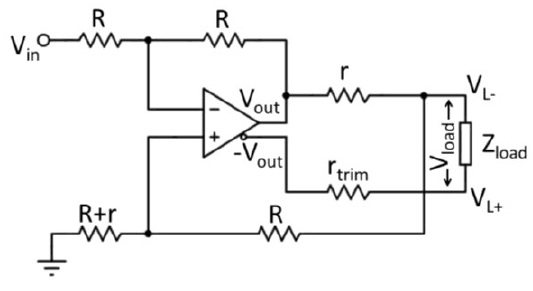
Fig.3: Enhanced Howland Current Source with differential amplifier